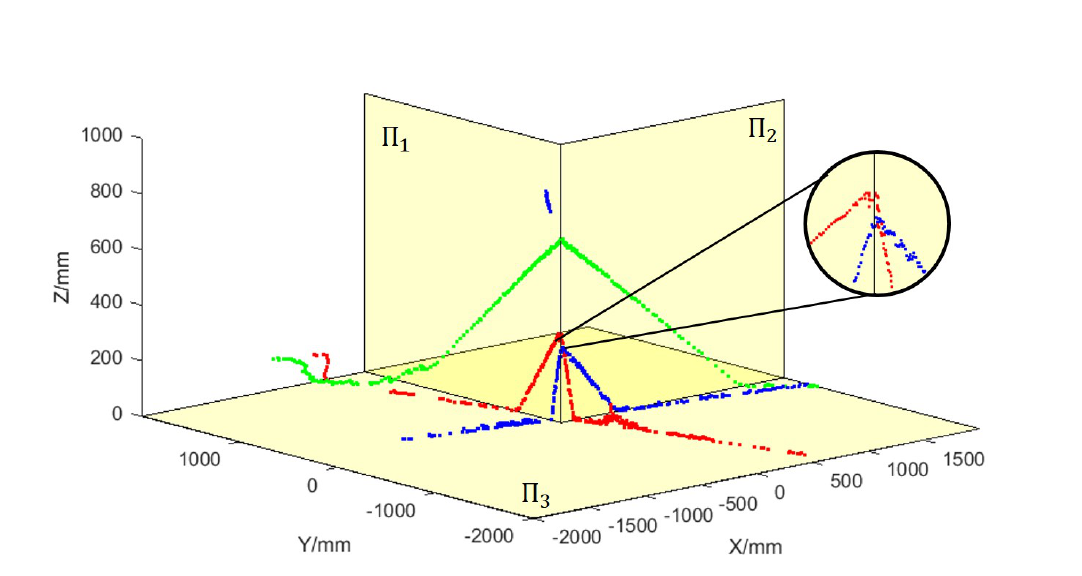
Figure 11. Results of three LRFs’ points inverted into the world coordinate system.